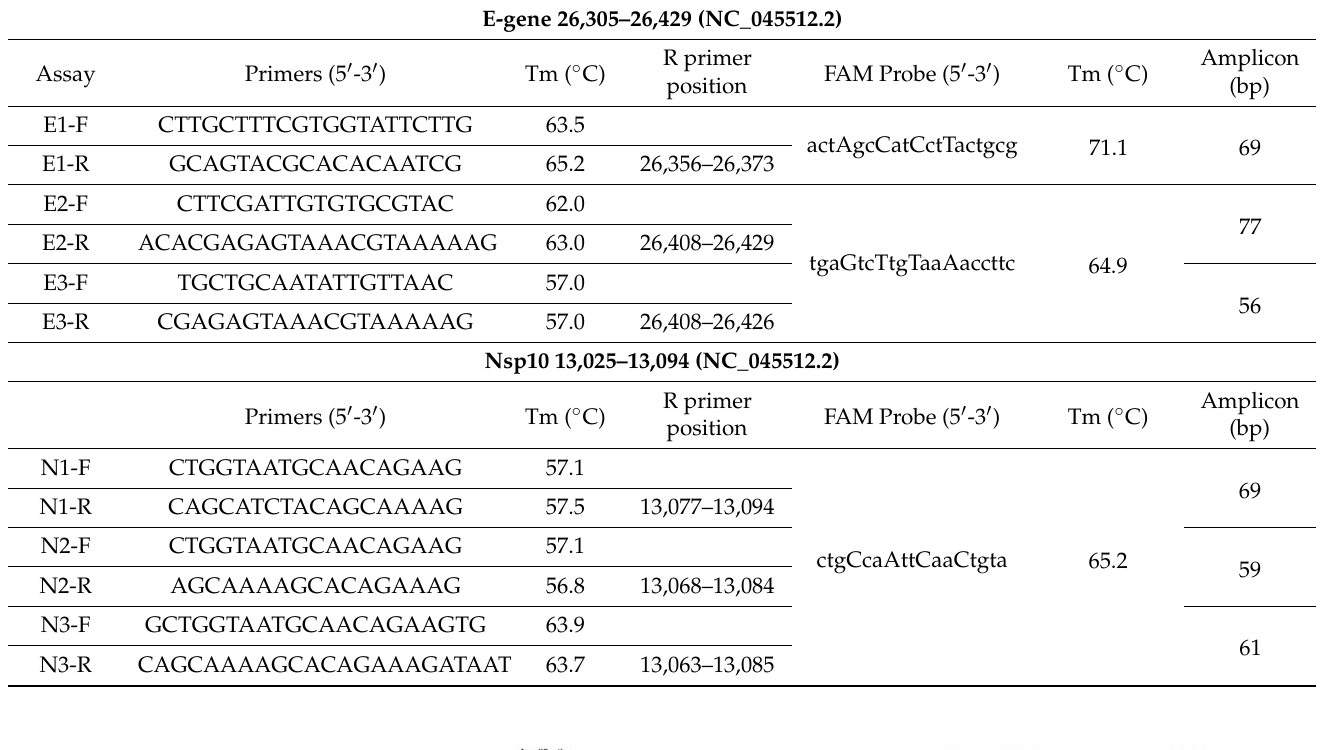
Table 1. Primer, probe and amplicon sequences and characteristics for the six assays targeting SARS-CoV-2 RNA. Capital letters within the probe sequences mark LNA substitutions.